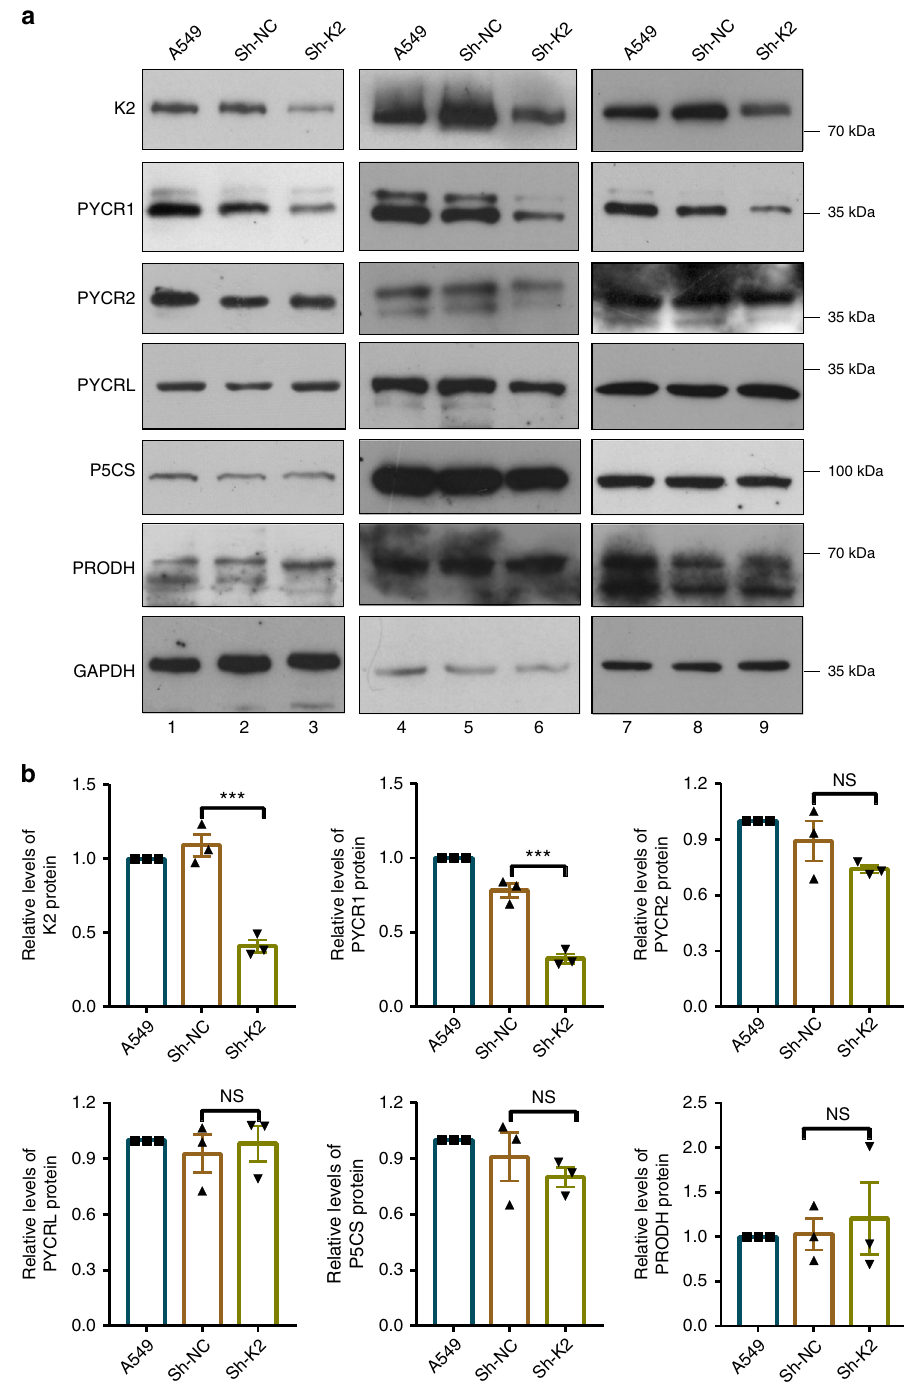
Fig. 3 The effects of kindlin-2 depletion on PYCR, P5CS, and PRODH levels. a A549 cells were infected with control (Sh-NC) or kindlin-2 shRNA (Sh-K2) lentivirus for 5 days and then analyzed by western blot with antibodies recognizing kindlin-2, PYCR1, PYCR2, PYCRL, P5CS, PRODH, and GAPDH (as a loading control). Three independent experiments were shown. b Protein levels of kindlin-2, PYCR1, PYCR2, PYCRL, P5CS, and PRODH relative to that of GAPDH in Sh-NC and Sh-K2 cells were quanti fi ed by densitometric analysis of western blottings and compared with those in the A549 cells (normalized to 1, n = 3). Data represent mean ± SEM from three independent experiments using one-way ANOVA with Tukey – Kramer post-hoc analyses, *** p < 0.001, NS, no signi fi